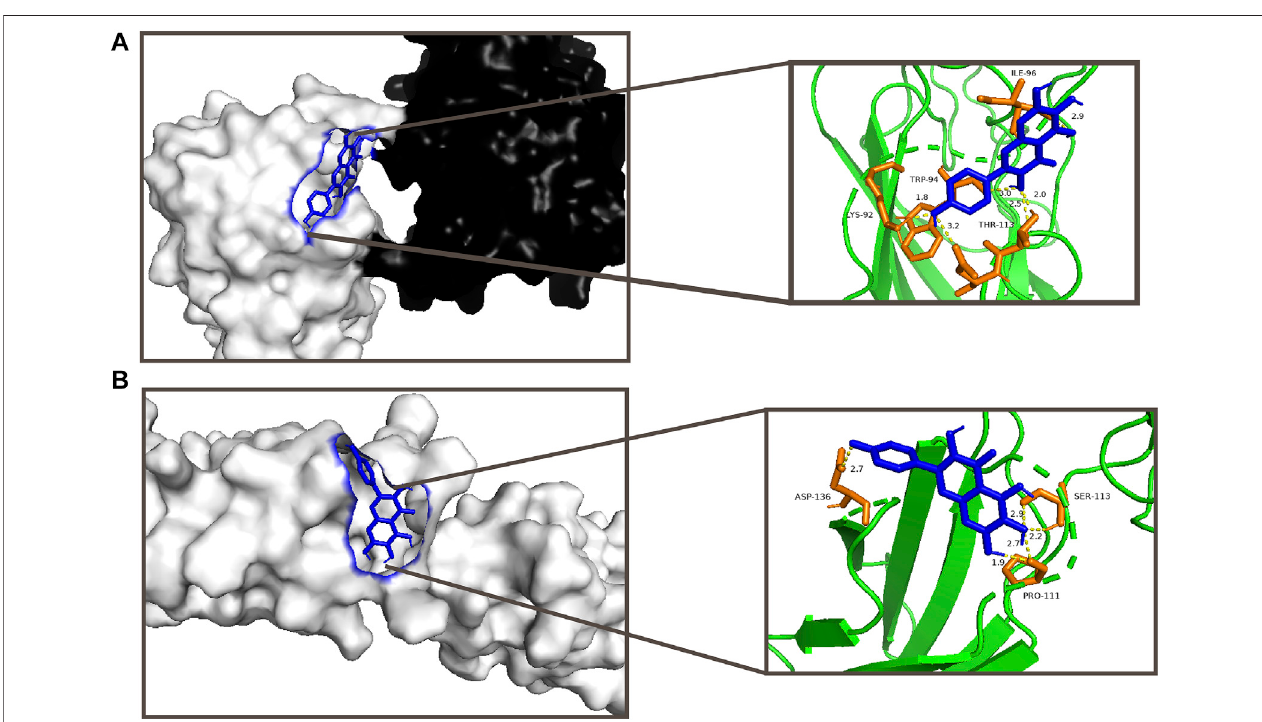
FIGURE 3 | Visual analysis of compounds with higher scores and more stable conformation and target proteins by the docking study; (A) interaction between 6- hydroxykaempferol and Col1a1 with an af fi nity of − 4.63 kcal/mol; (B) interaction between 6-hydroxykaempferol and TNC with an af fi nity of − 5.21 kcal/mol.